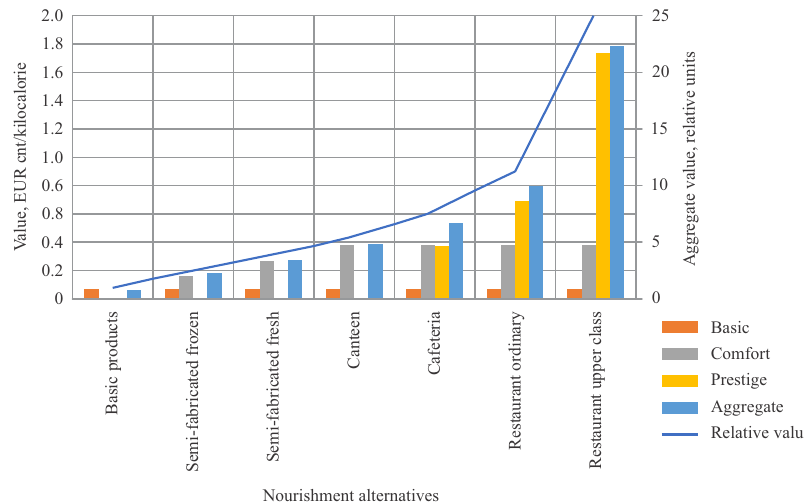
Nourishment Fig. 4. Influence of nourishment type on the kilocalorie price of the same dish